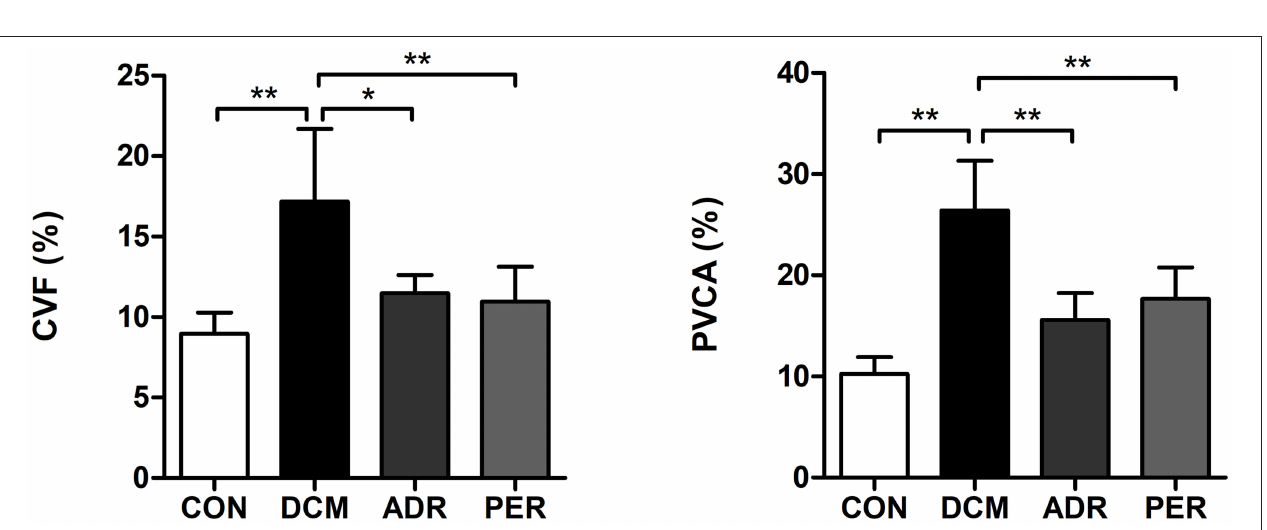
FIGURE 2 | Effects of ADR on CVF and PVCA of myocardial tissue in DCM rats. Compared to DCM group, CVF and PVCA decreased in ADR and PER group. CON, control; DCM, diabetic cardiomyopathy; ADR, adropin; PER, perindopril; CVF, collagen volume fraction; PVCA, perivascular collagen volume area. Values are expressed as mean ± standard deviation. * P < 0.05, ** P <